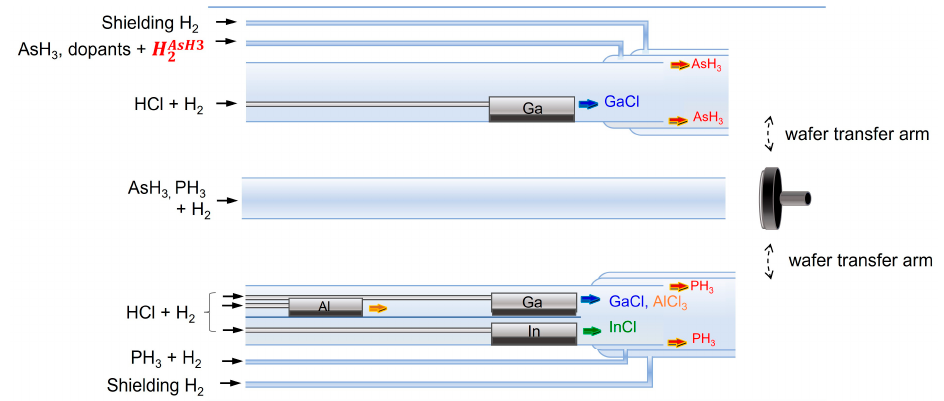
Figure 1. Schematic of the growth chambers in the custom-built hydride vapor phase epitaxy (HVPE) reactor. Dashed arrows indicate the direction of movement of the mechanical transfer arm between the preparation chamber and each growth chamber.